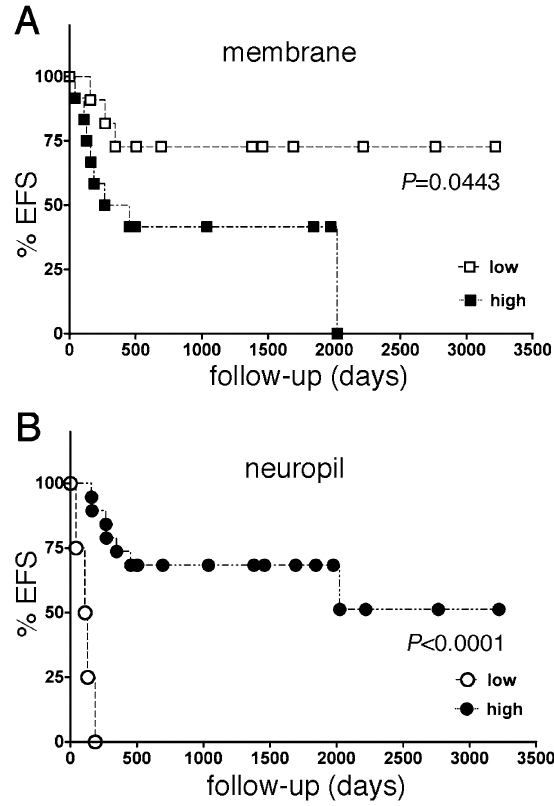
Fig. 6. ALCAM expression and event-free survival of patients with localized NB. Patients were stratified according to the semi quantita- tive grading of ALCAM expression (low = + / − or + , high = ++ or +++ ) in membrane (A) or neuropil area (B). Difference in event free survival (EFS) between patients with high or low ALCAM ex- pression in the membrane was significant ( P = 0 . 0443), and dif- ference in EFS between patients with high or low expression in the neuropil area was highly significant ( P < 0 .